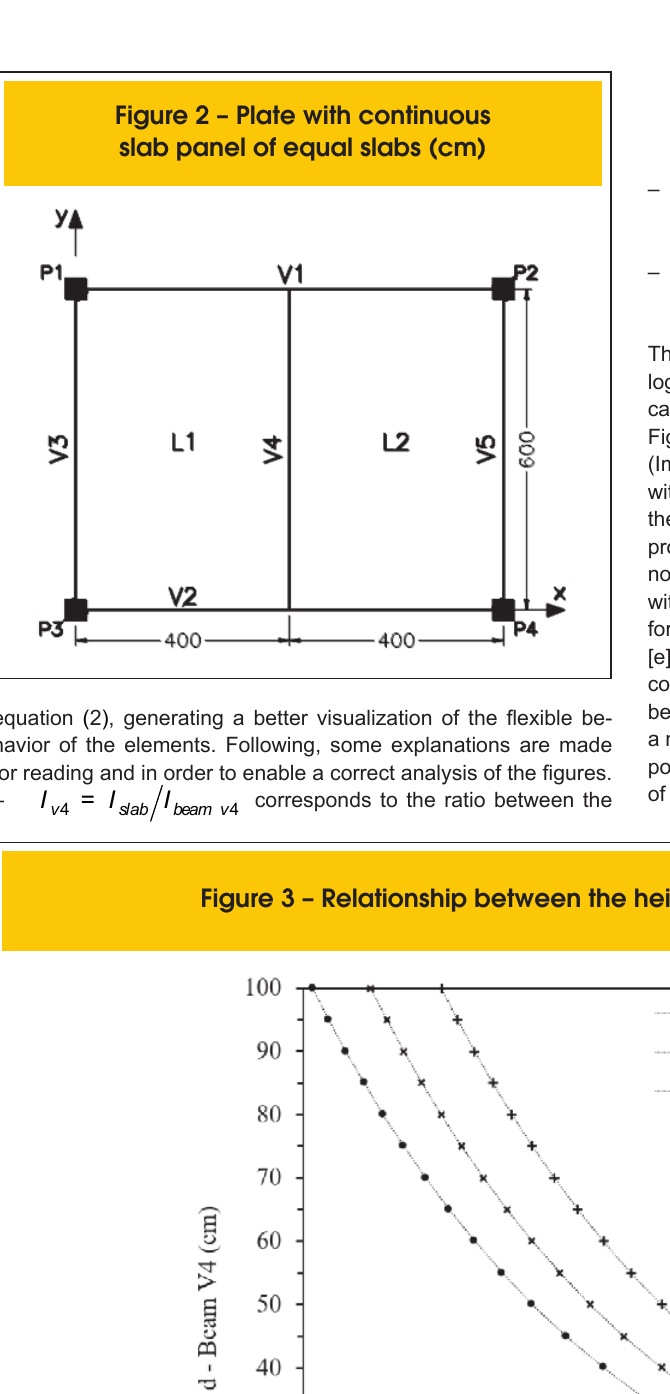
Figure 2 – Plate with continuous slab panel of equal slabs (cm)